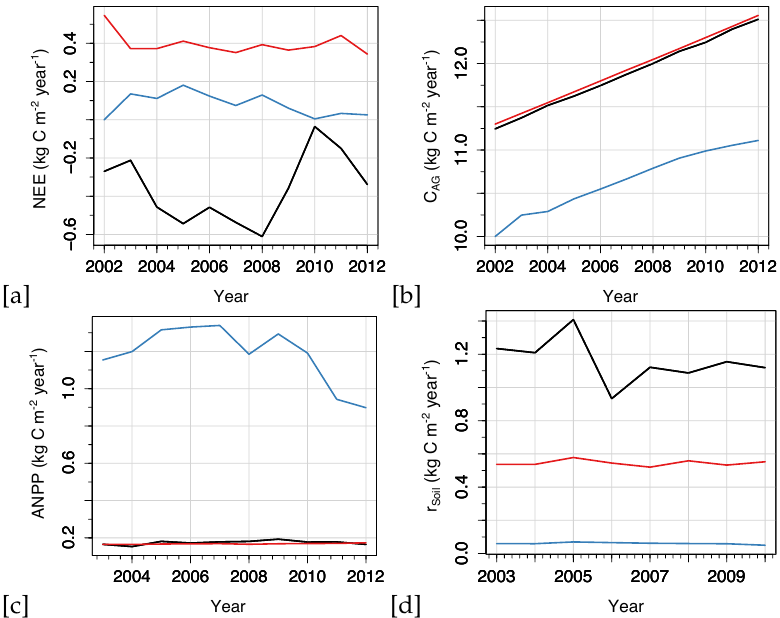
Figure 6. Simulated and observed NEE, C AG , ANPP, and r Soil for the HF-EMS site; black = observations; red = PPA-SiBGC; blue = LANDIS-II NECN; ( a ) = NEE; ( b ) = C AG ; ( c ) = ANPP; ( d ) = r Soil